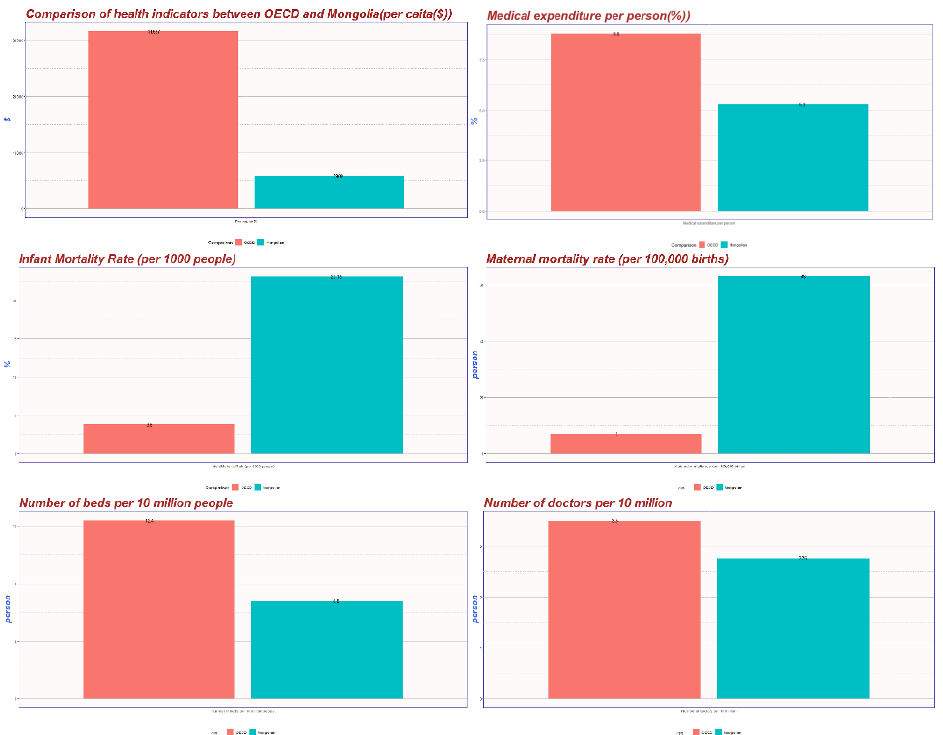
Figure 4. Comparison of average indicators of Mongolia and OECD virtualization using R program- ming language.